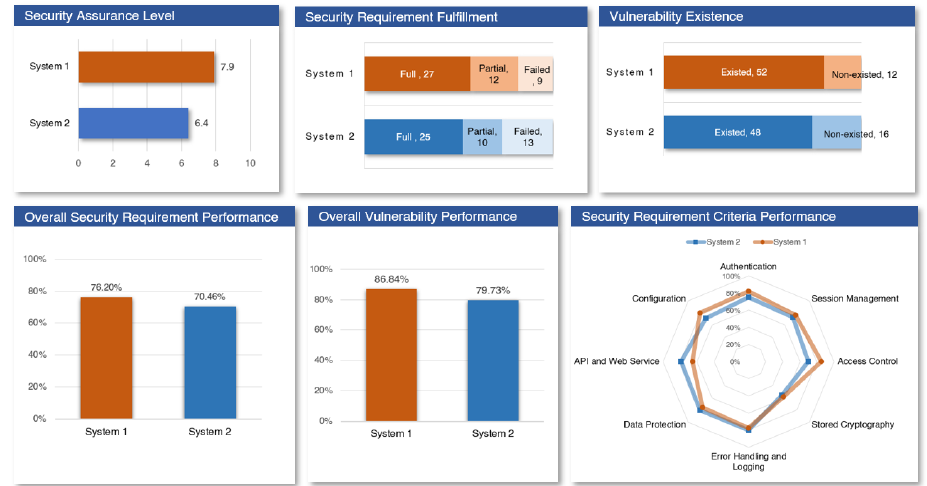
Figure 7. Security assurance analytics dashboard—multiple systems view.